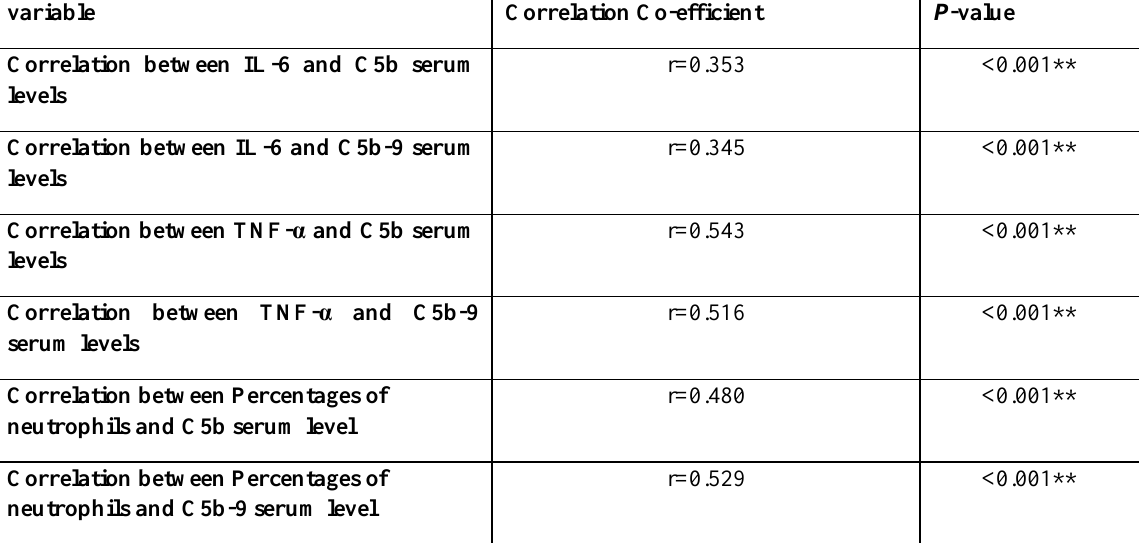
Table 4. Correlation of IL-6, TNF-α, and neutrophil percentages from one side with C5b and C5b-9 serum levels from the other side in COVID-19 patients with different severities.